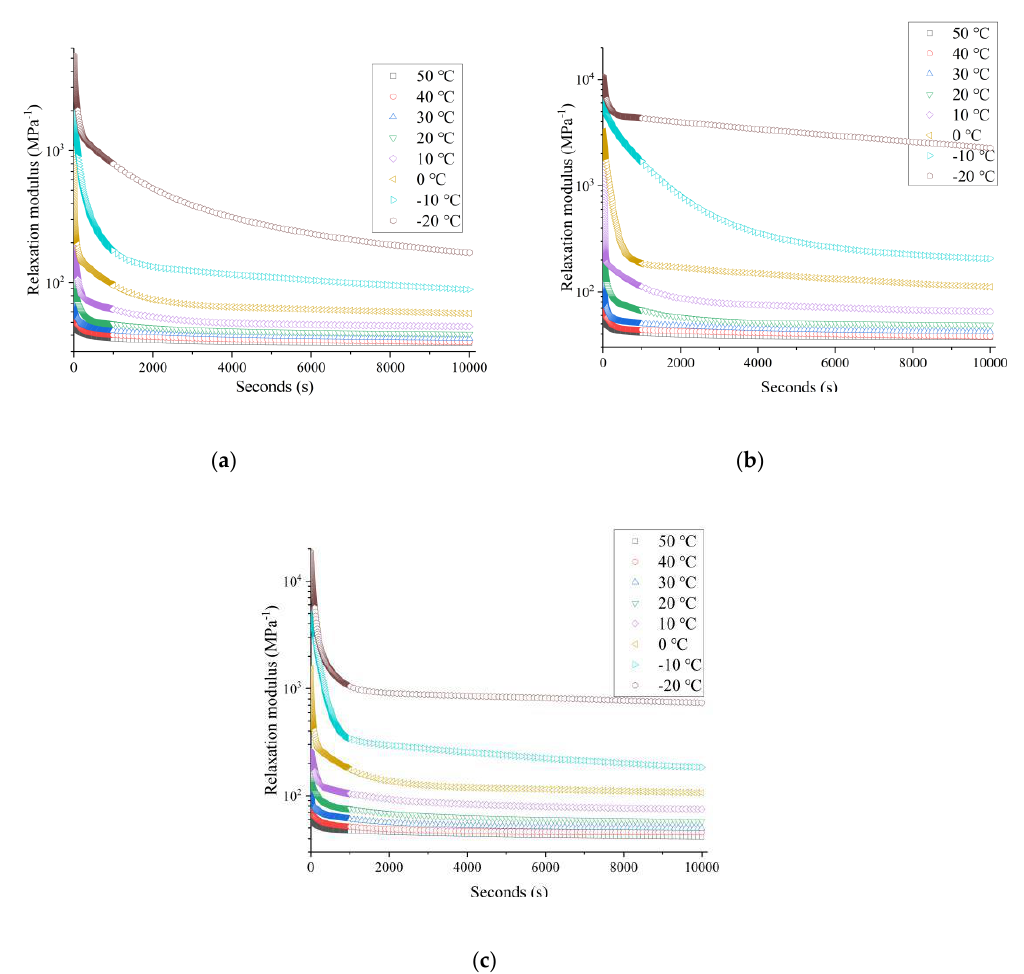
Figure 6. Relaxation moduli at different temperatures: ( a ) AM; ( b ) DBFAM; ( c ) SBSAM.